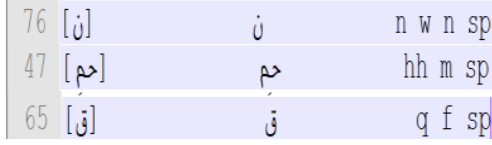
Figure 5. Medd Lazim Harfi in Arabic phonetic dictionaries.